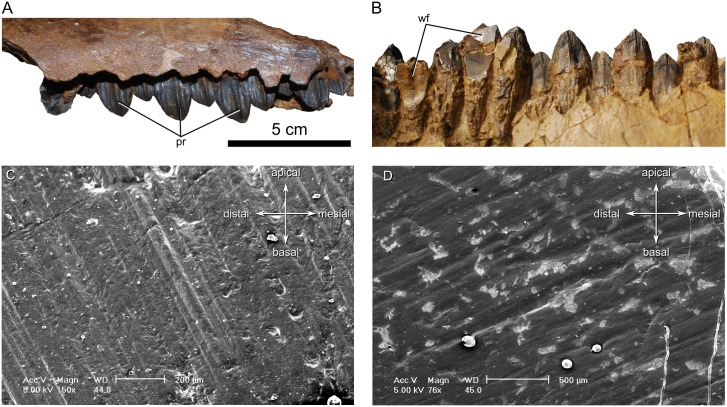
Teeth of Spiclypeus shipporum gen et sp. nov. (CMN 57081).(A) Left maxillary teeth in lateral view; (B) right dentary teeth in lateral view. (C) microwear on the 23rd right dentary tooth showing common dorsodistally-ventromesially oriented scratches; (D) microwear on the 13th right dentary tooth showing less common dorsomesially-ventrodistally oriented scratches.